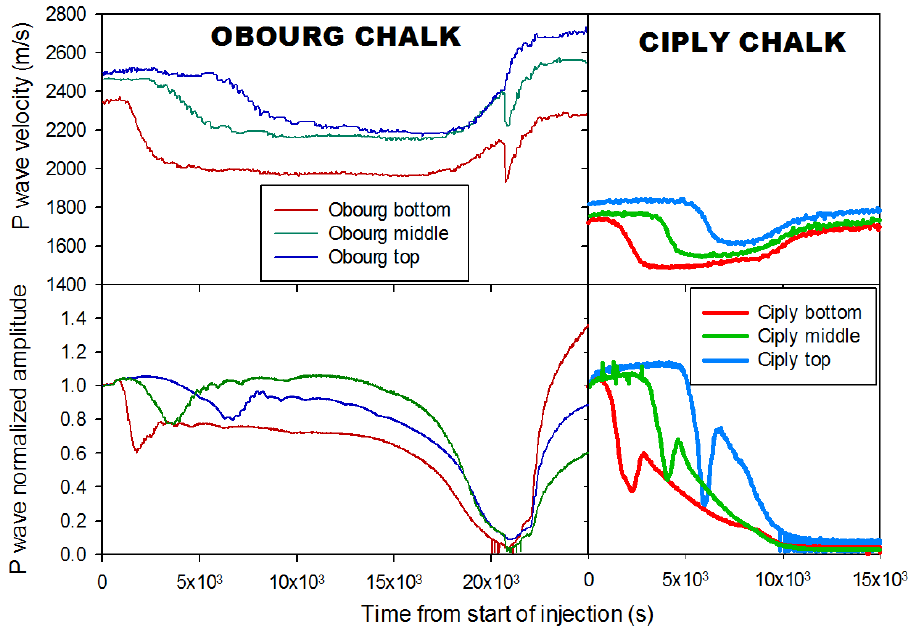
Figure 13. Results for acoustic monitoring of the P wave velocity ( top ) and amplitude ( bottom ) during injection tests in Obourg ( left ) and Ciply ( right ) Chalks at 1.5 MPa confining pressure. The different colors correspond to measurements at different heights in the bottom (red), middle (green), and top (blue) planes. The velocity and amplitude scale are the same for the Obourg and Ciply Chalks plots.